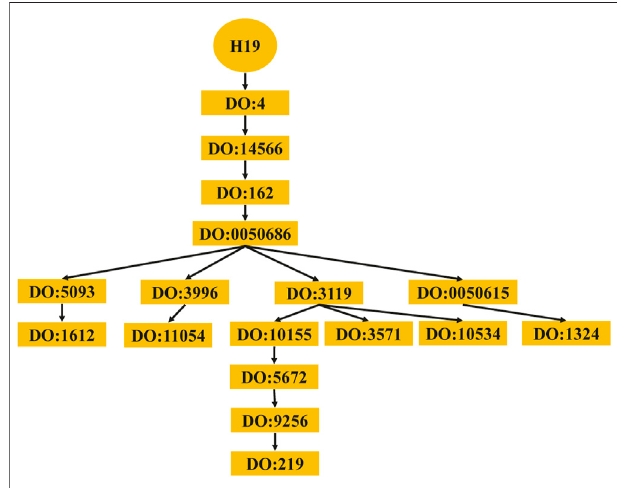
FIGURE 3 | Diseases associated with lncRNA H19. lncRNA, long noncoding RNA.